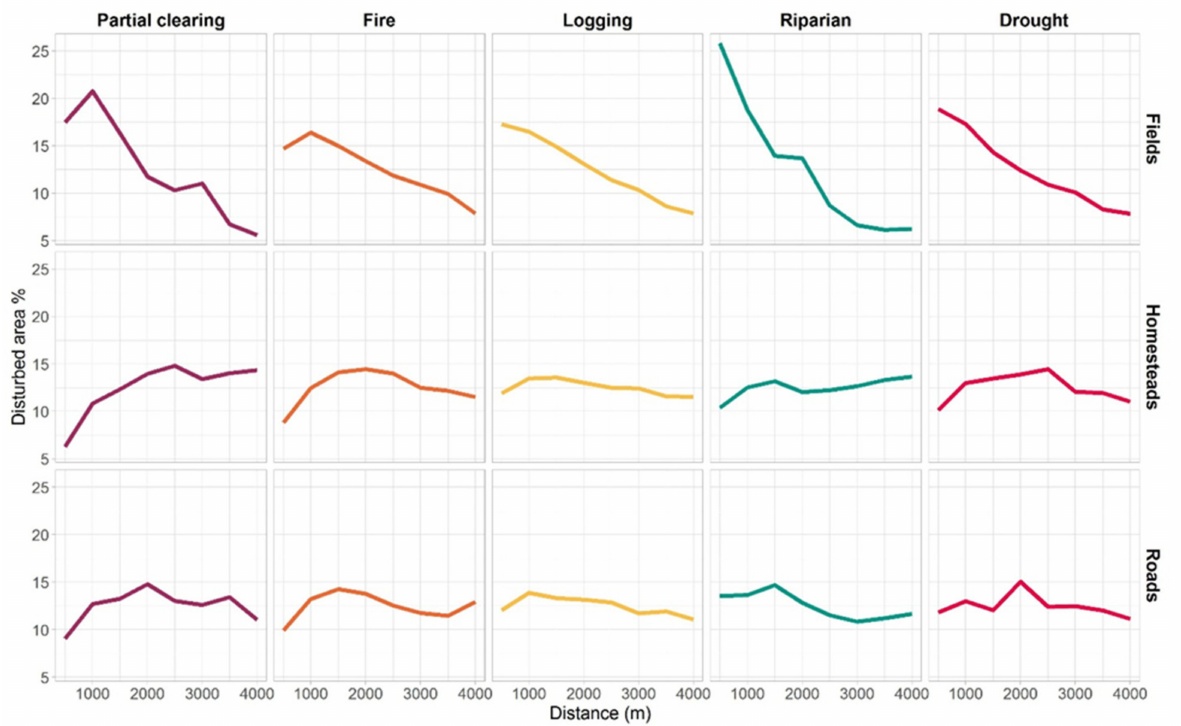
Figure 7. Disturbance agents in relation to distance to agricultural fields, smallholders’ homesteads and